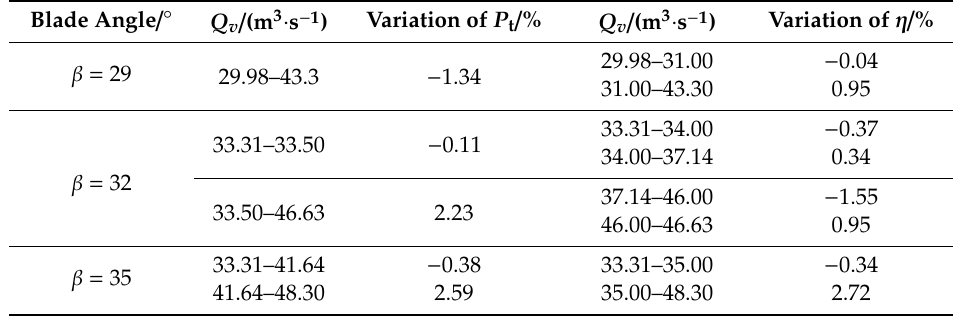
Figure 7. Effect of forward-skewed blades on fan performance with different blade pitch angles. ( a ) Figure 7. E ff ect of forward-skewed blades on fan performance with di ff erent blade pitch angles. ( a ) total pressure rise; ( b ) e ffi ciency. total pressure rise; ( b ) efficiency. Table 4. E ff ect of forward-skewed blades on total pressure and e ffi ciency at three blade pitch Table 4. Effect of forward-skewed blades on total pressure and efficiency at three blade pitch angles.